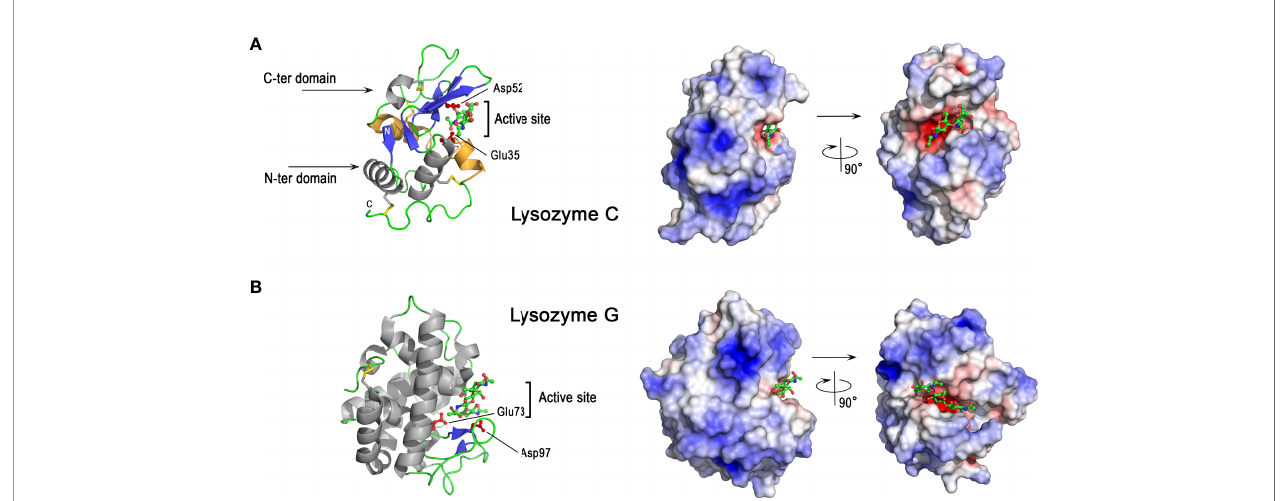
FIGURE 5 | 3D structures of avian lysozymes, lysozyme C and lysozyme G 3D structure of chicken lysozyme C (A) and goose lysozyme G (B). The left panels correspond to the cartoon representation of 3D structure while the right panels show the color-coded electrostatic potential molecular surface. Color scheme ranges from red (negatively charged regions) to deep blue (positively charged regions). The fi gure shows a disaccharide of N-acetyl-glucosamine bound in the active site of lysozyme C while the structure of lysozyme G is shown as a complex with a trisaccharide of N-acetyl glucosamine (green and red, balls-and-stick representation). The fi gure was prepared using Pymol software (48) and APBS (Adaptive Poisson-Boltzmann Solver) plugin (49) for electrostatic calculations using atomic coordinates of 1SF4 and 154L PDB fi le for hen egg white lysozyme C and goose lysozyme G,